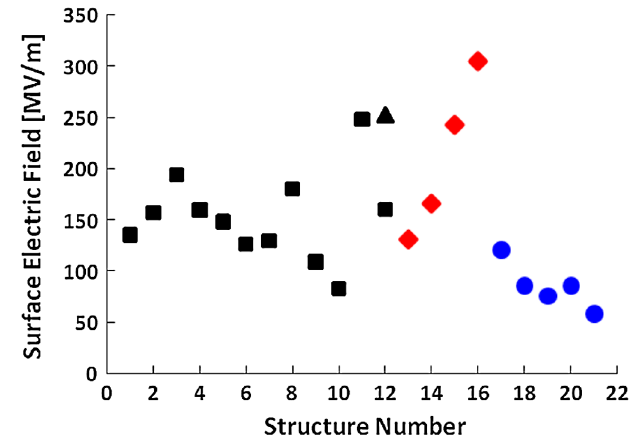
FIG. 4. (Color) Surface electric field is plotted for the data presented in Fig. 3.